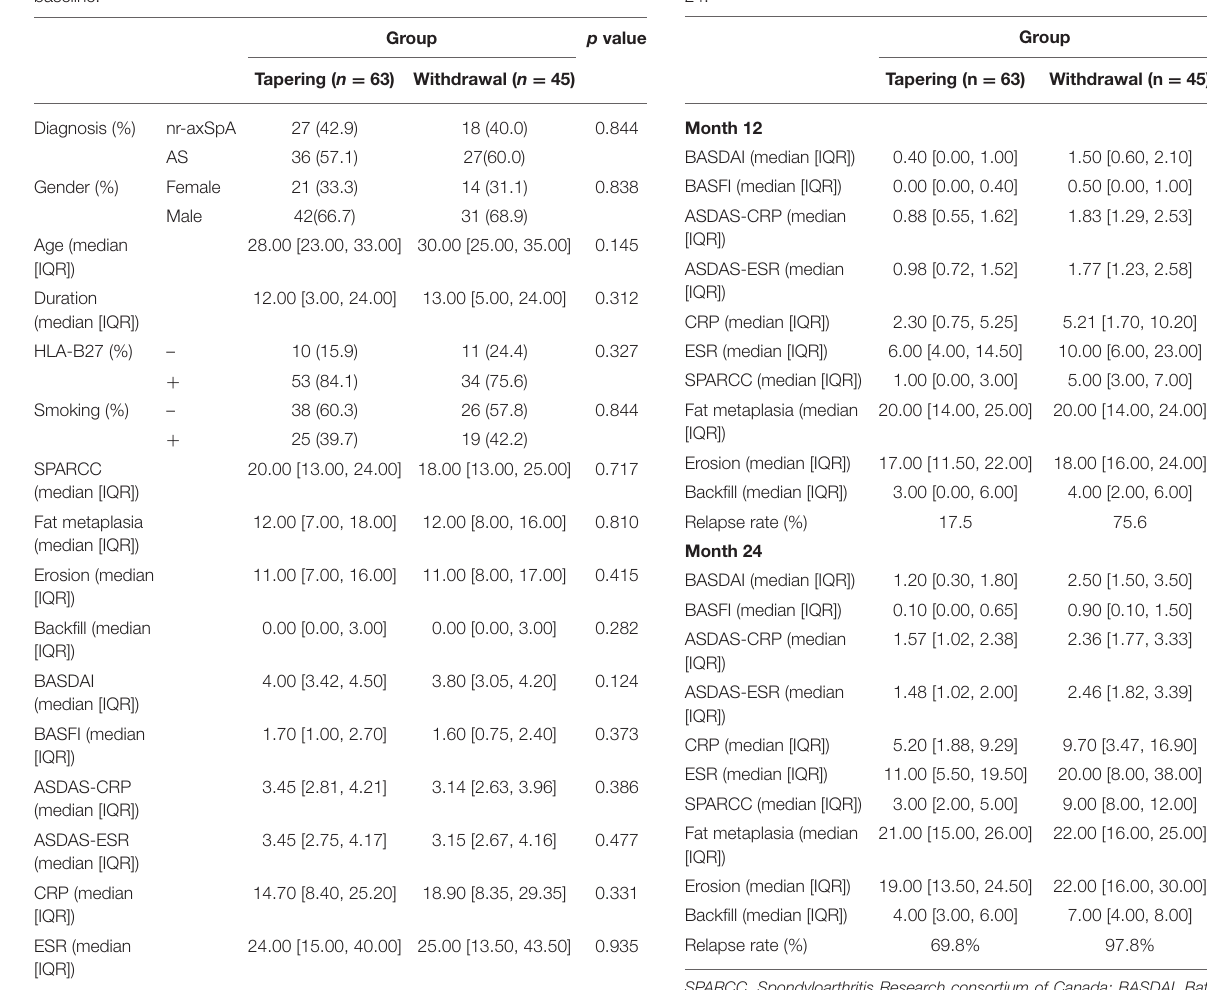
TABLE 2 | Characteristic of disease activity and MRI features at months 12 and 24.